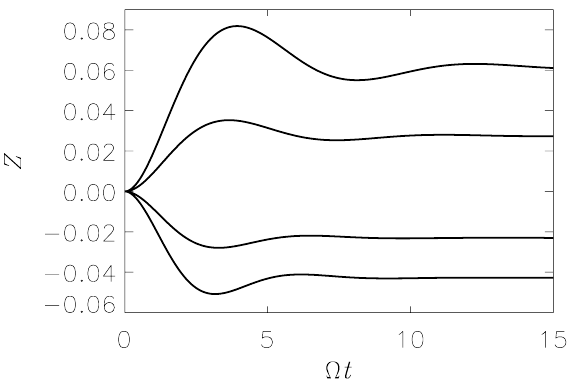
Fig. 5. Numerical solutions of Eq. (9) are shown for four amplitudes γ =± 0 . 15 and ± 0 .